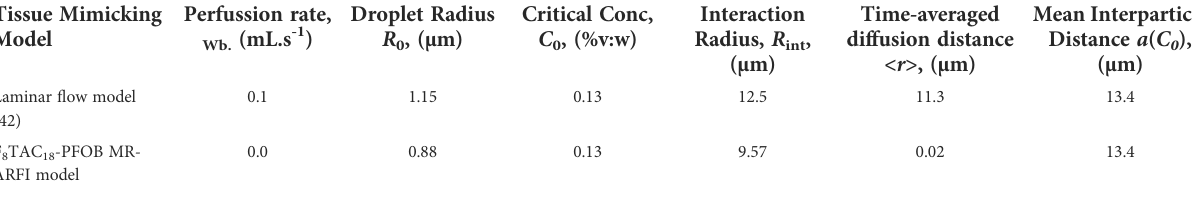
TABLE 4 Comparison of theoretical diffusion distance, interparticle distance, interaction radius, and critical concentration across this study and previous studies. Tissue Mimicking Model